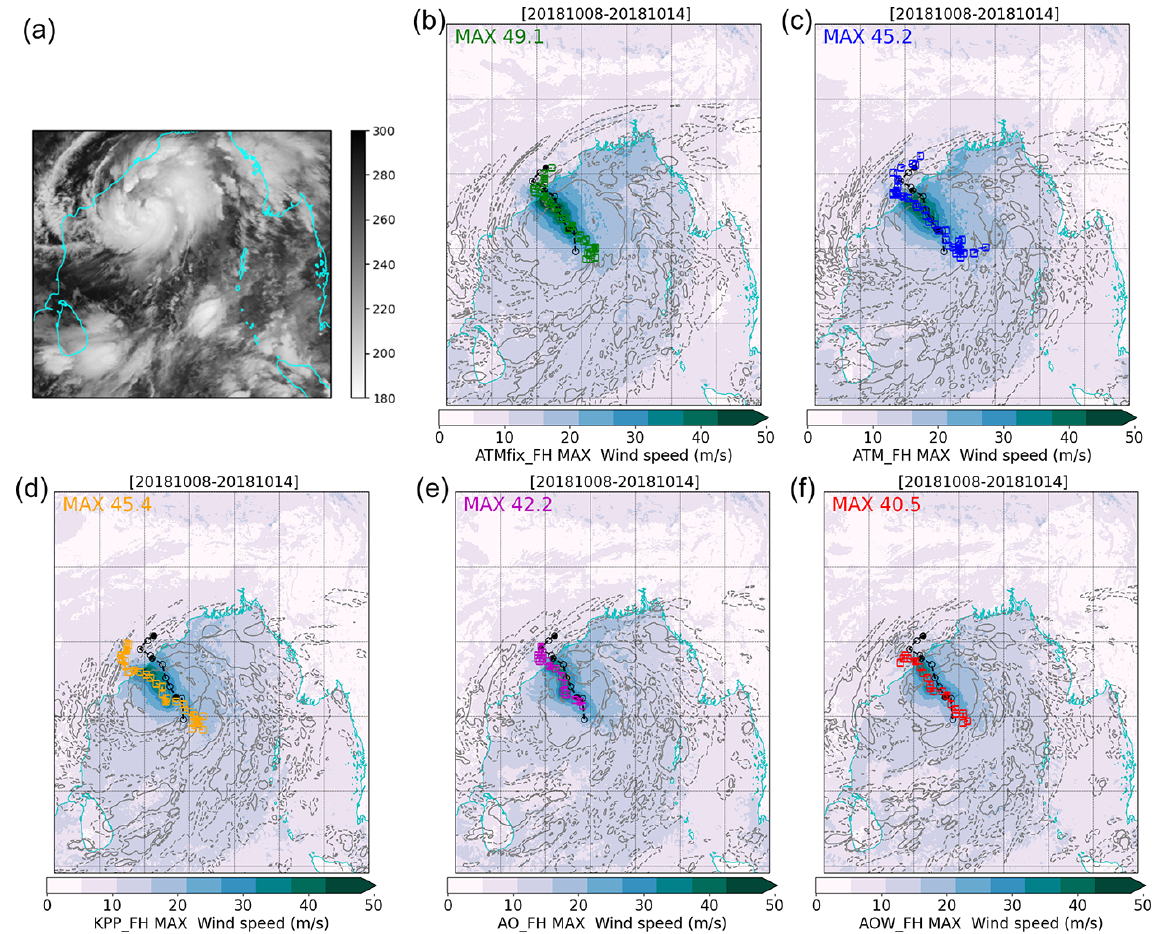
Figure 5. (a) Illustration of Cyclone Titli satellite-observed brightness temperature from Meteosat at 00:00UTC on 10 October 2018. In (b) – (f) , results from RCS-IND1 experiments showing maximum wind speed during the 7d simulation (coloured shading). Also plotted is the diagnosed simulated cyclone track at 3-hourly intervals (coloured line and squares) compared with observed track at 6-hourly intervals (black line and circles). Line contours show instantaneous simulated outgoing longwave radiation at top of atmosphere (dashed line indi- cating 150Wm − 2 , solid line 100Wm − 2 contour) at coincident hour to the satellite observation in (a) . See Fig. S1 in the Supplement for corresponding figure for simulations without frictional heating